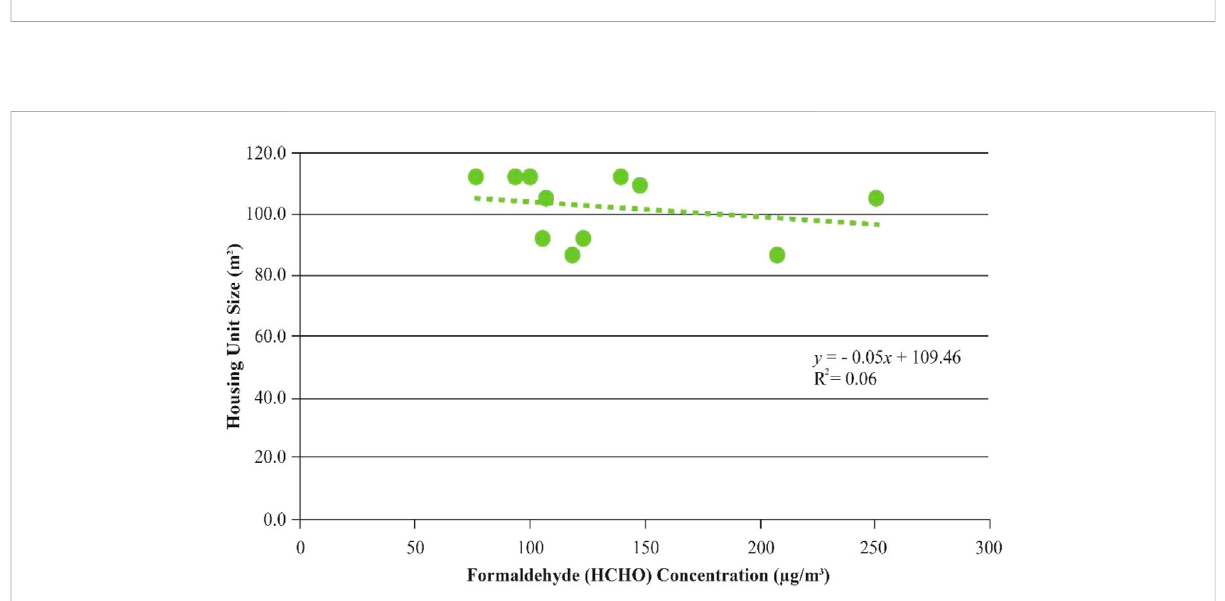
FIGURE 14 Relationship between formaldehyde (HCHO) concentration and housing unit